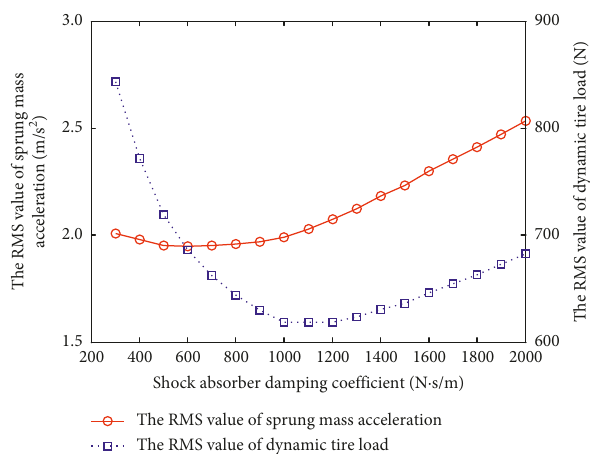
Figure 10: Relationship between the variable damping and the riding comfort, handling, and stability of vehicle at 100km/h speed.